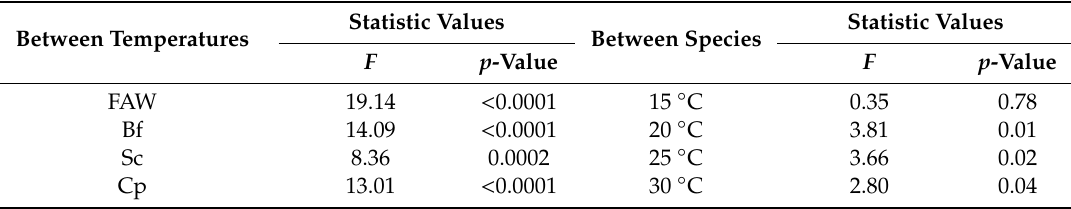
FAW = Spodoptera frugiperda , Bf = Busseola fusca , Sc = Sesamia calamistis , Cp = Chilo partellus